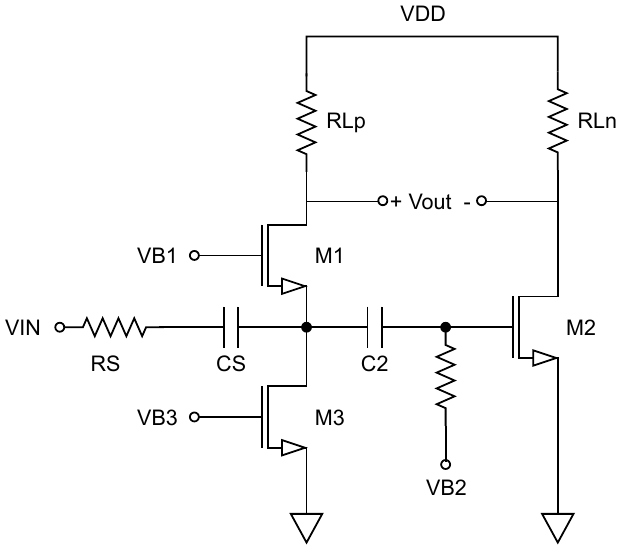
Figure 1. CG-CS Noise-Canceling